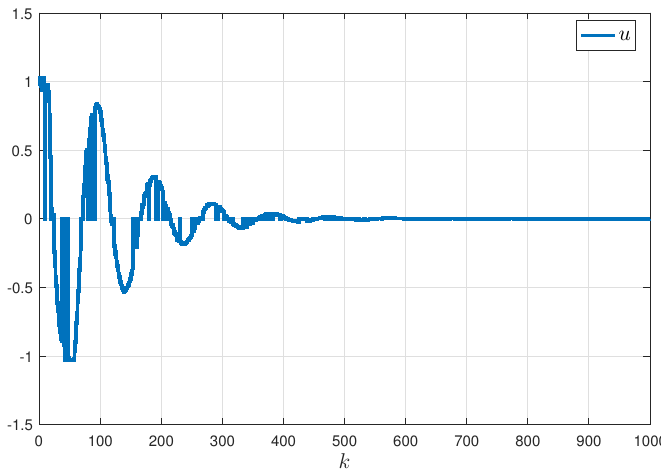
Figure 15. Control response u ( k )